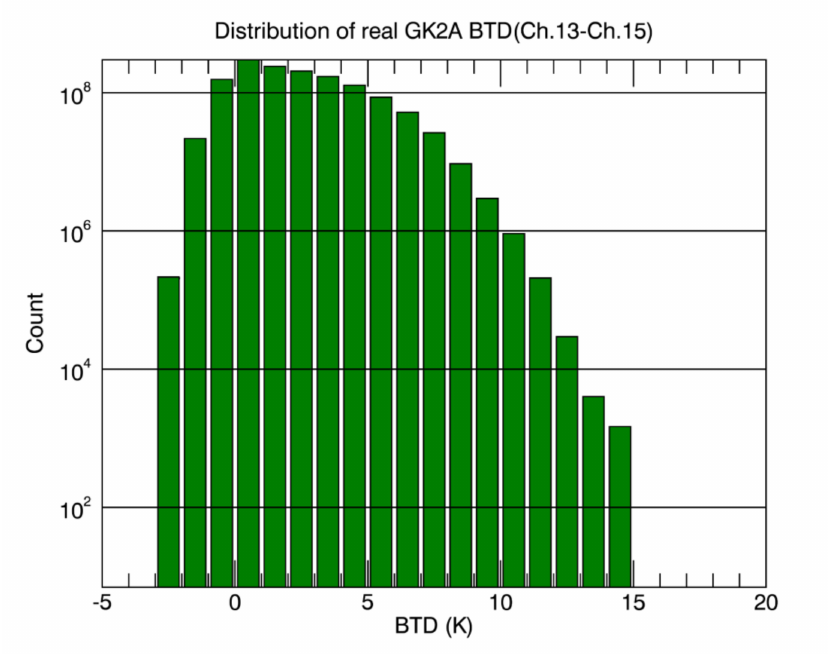
Figure 3. Distribution of brightness temperature di ff erence between channel 13 and channel 15 of GK2A for selected days (25 July 2019; 25 August 2019; 22 September 2019; and 4 October 2019).